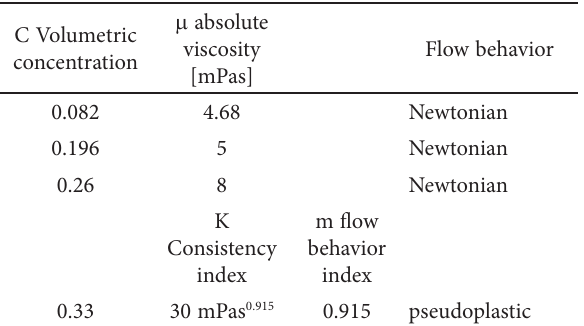
Table 3. Flow properties of sand glass from Fehérvárcsúrgó = 20.4 m m, r = 2734 kg/m 3 ( x 90 s